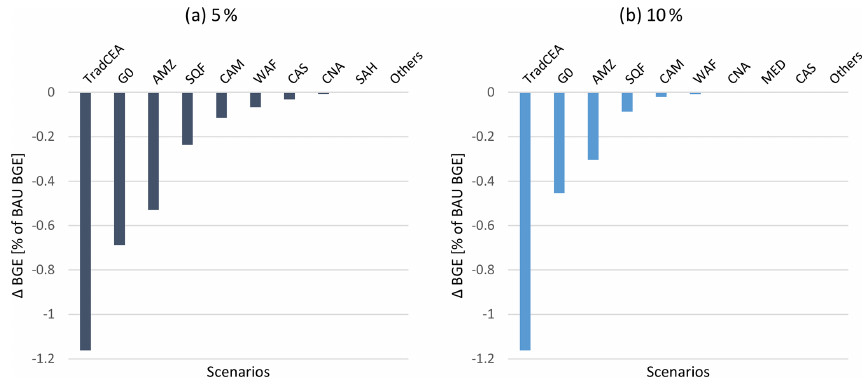
Figure 5. Mitigation costs for a step-wise omission of regional precipitation guardrails. “TradCEA” is a 2 ◦ C policy without SRM usage; “G0” is a 2 ◦ C policy when SRM is included, and all regional precipitation guardrails are active; 5% and 10% denote the fraction of the standard deviation of natural variability as the extra admissible area. Balanced growth equivalent (BGE) values attributed to a region are the loss in comparison to a no-policy (BAU – business-as-usual) scenario if the analysis is henceforth not constrained by the precipitation guardrails of the respective region. The acronyms of regions are defined in Table